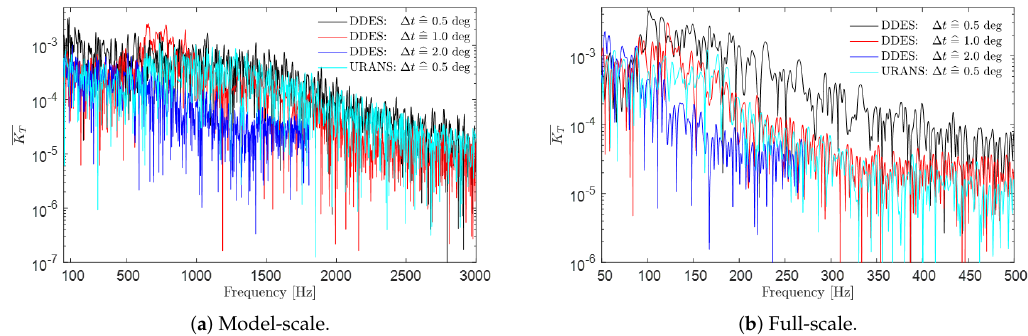
Figure 21. Propeller thrust coefficient in the frequency domain for PPTC Case